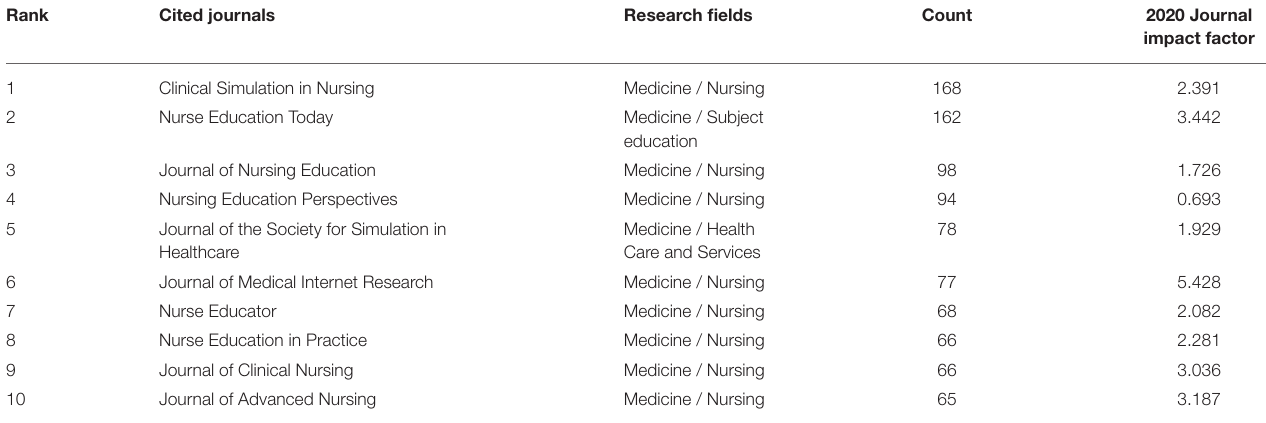
TABLE 4 | The top 10 cited journals of publications on the application of VR in nursing from 2012 to 2021.